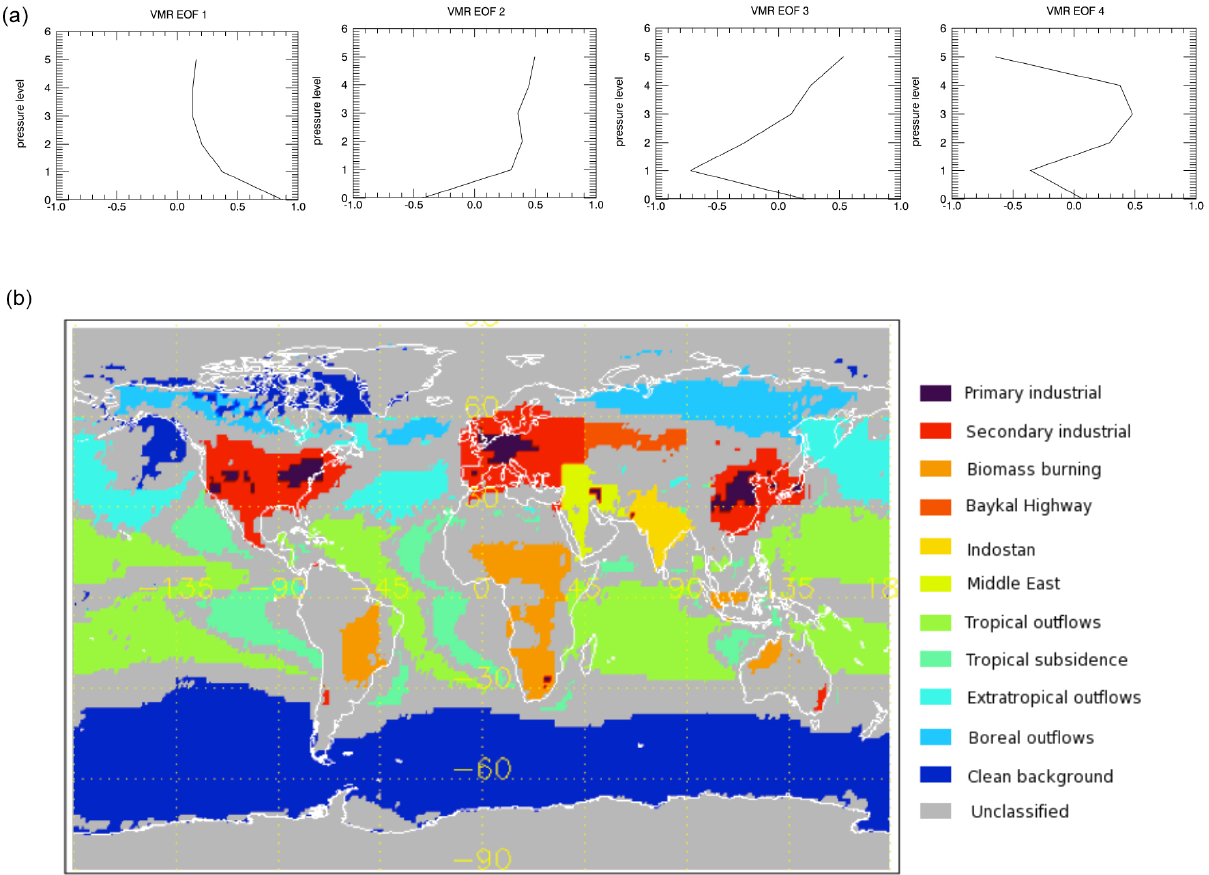
Figure 7. (a) Classification EOFs: surface source, outflow, high/low outflow, and middle outflow. (b) Model-based classes based on EOF decomposition of model NO 2 profiles under cloudy conditions: black (primary industrial), red (secondary industrial), orange (biomass burning), ochre (Baykal Highway), yellow (Indostan), light green (Middle East), green (tropical outflow), turquoise (tropical subsidence), cyan (extratropical outflow), blue (boreal outflow), and dark blue (clear background). Gray means